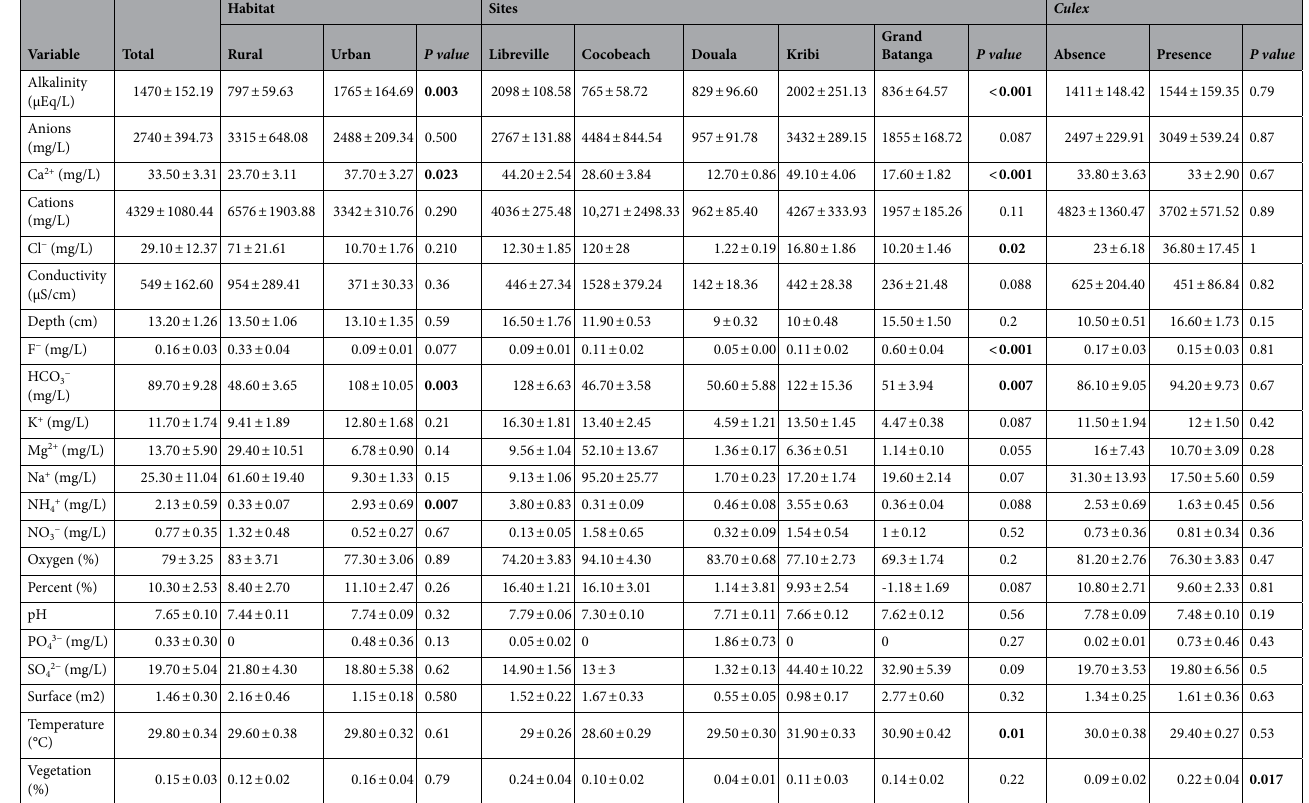
Table 2. Effect of the habitat on the physicochemical parameters of breeding sites. Data are the mean ± standard error; P-values were estimated with the Fisher’s exact test. Significant P-values are in bold. See Table S1 for the complete list of variables at each breeding